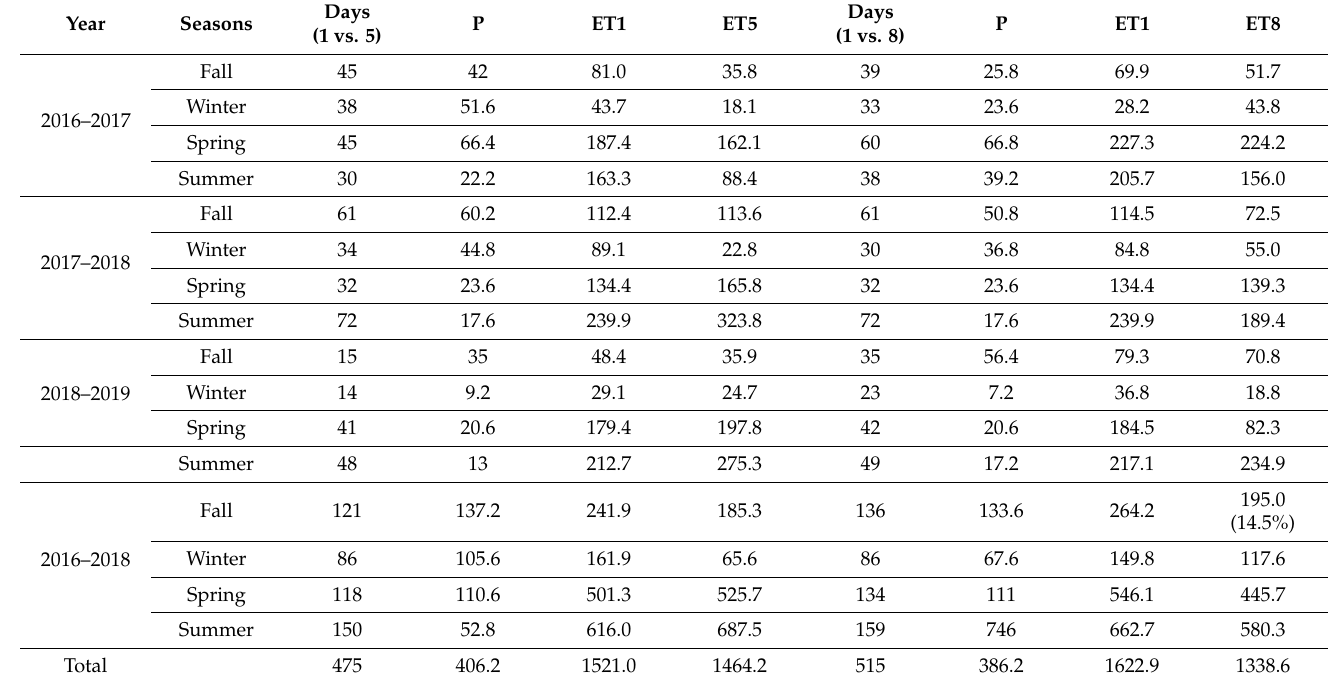
Table A6. Cumulative ET and P in mm for the lysimeters in common validated days for reference